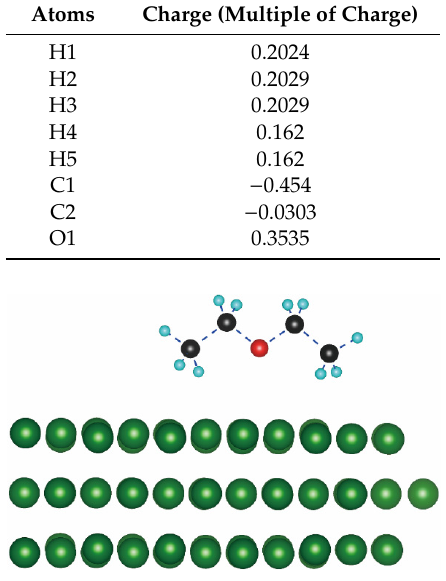
Figure 4. Snapshot of an ether molecule adsorbed on a long bridge site of Fe (110) supercell.